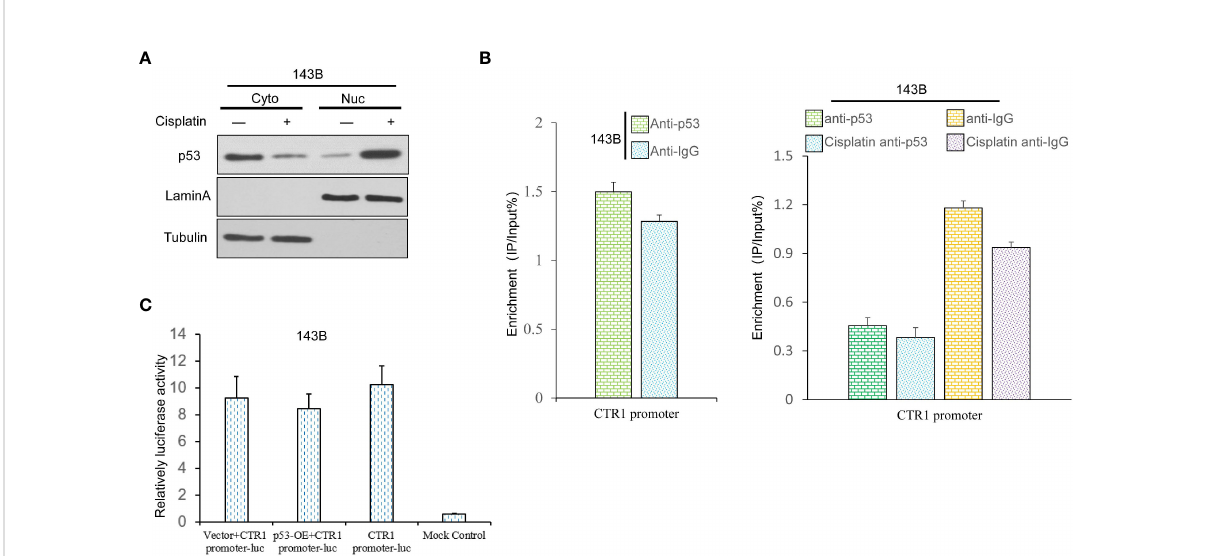
FIGURE 4 The p53 gene possesses a non-direct regulation effect on CTR1 promoter in OS cells. (A) The in fl uence of cisplatin (10 m g/ml) on p53 nuclear translocation was determined by nucleocytoplasmic separation in 143B cells. The blotting of Lamin A and Tubulin were used as internal control to determine the separation effect. (B) Sheared chromatin from p53 expression cells treated with or without cisplatin was used to perform ChIP assays in 143B cells, and immunoprecipitated DNA was analyzed by qPCR using primers comprising the CTR1 promoter region. Results are expressed as a percentage of input DNA compared to IgG. (C) The CTR1 luciferase reporter assay was performed using p53-OE and control 143B cells. The data are presented as means of the ratio of fi re fl y luciferase to renilla luciferase. Bars show mean ±